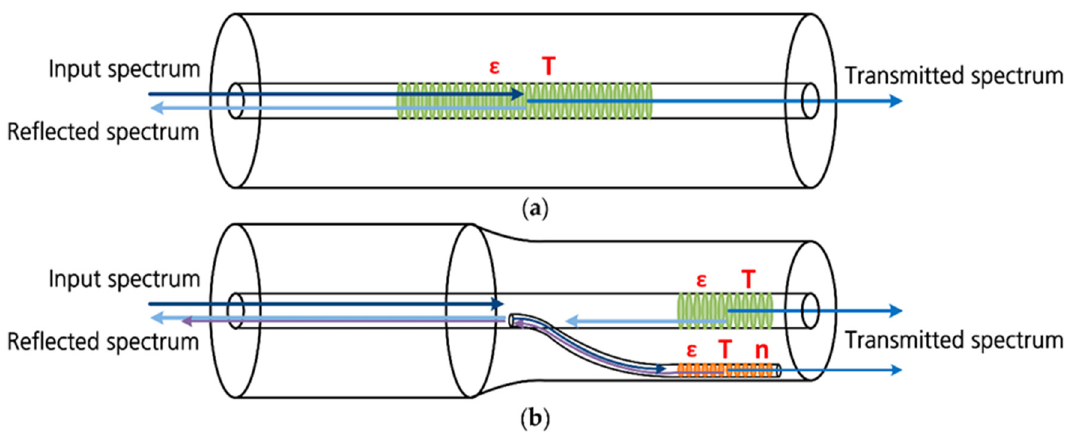
Figure 9. Schematics of typical and sensitivity-enhancing optical waveguide structure [127]: ( a ) the original design where gratings are inscribed into the fiber core; ( b ) the self-compensating design that can enhance refractive index sensitivity by inscribing an additional waveguide in the cladding to divert a portion of the propagating light.